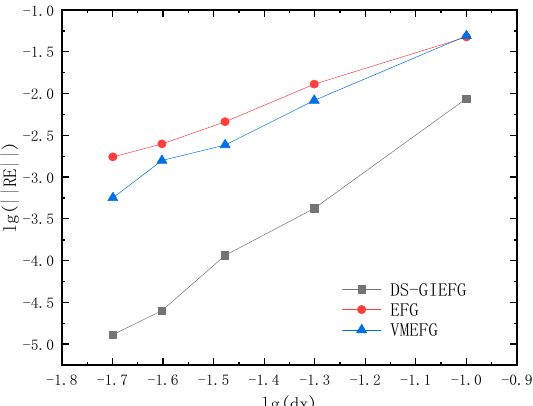
Figure 4. The variation of relative errors of the DS-GIEFG, VMEFG and EFG methods with respect to node spacing (in lg–lg scale).